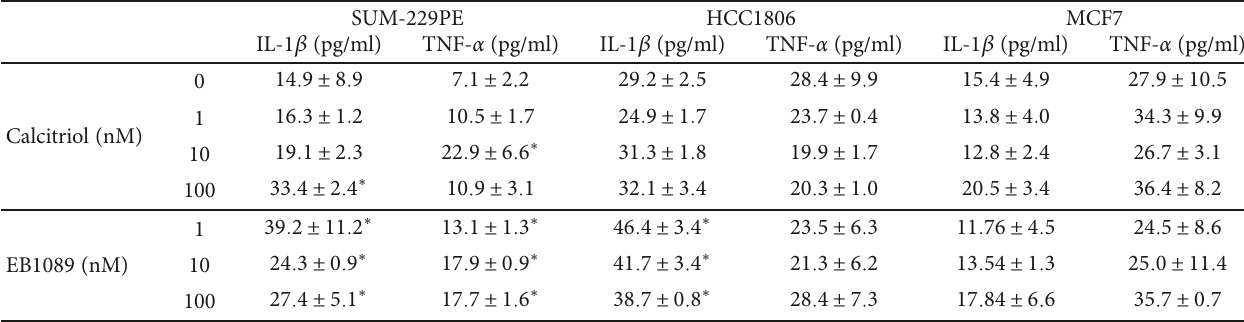
Results are expressed as the mean ± SD cytokine secretion of triplicate determinations and represent at least three di ff erent experiments. ∗ P < 0 05 vs. nontreated cells